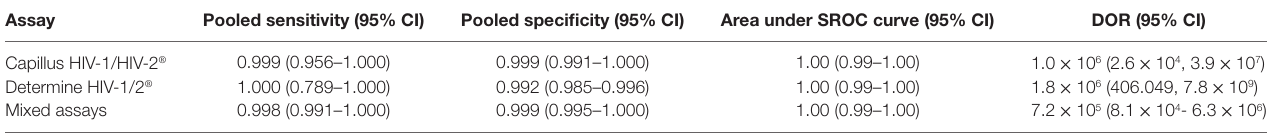
taBLe 2 | Diagnostic performance for three commonly used RT assays. assay